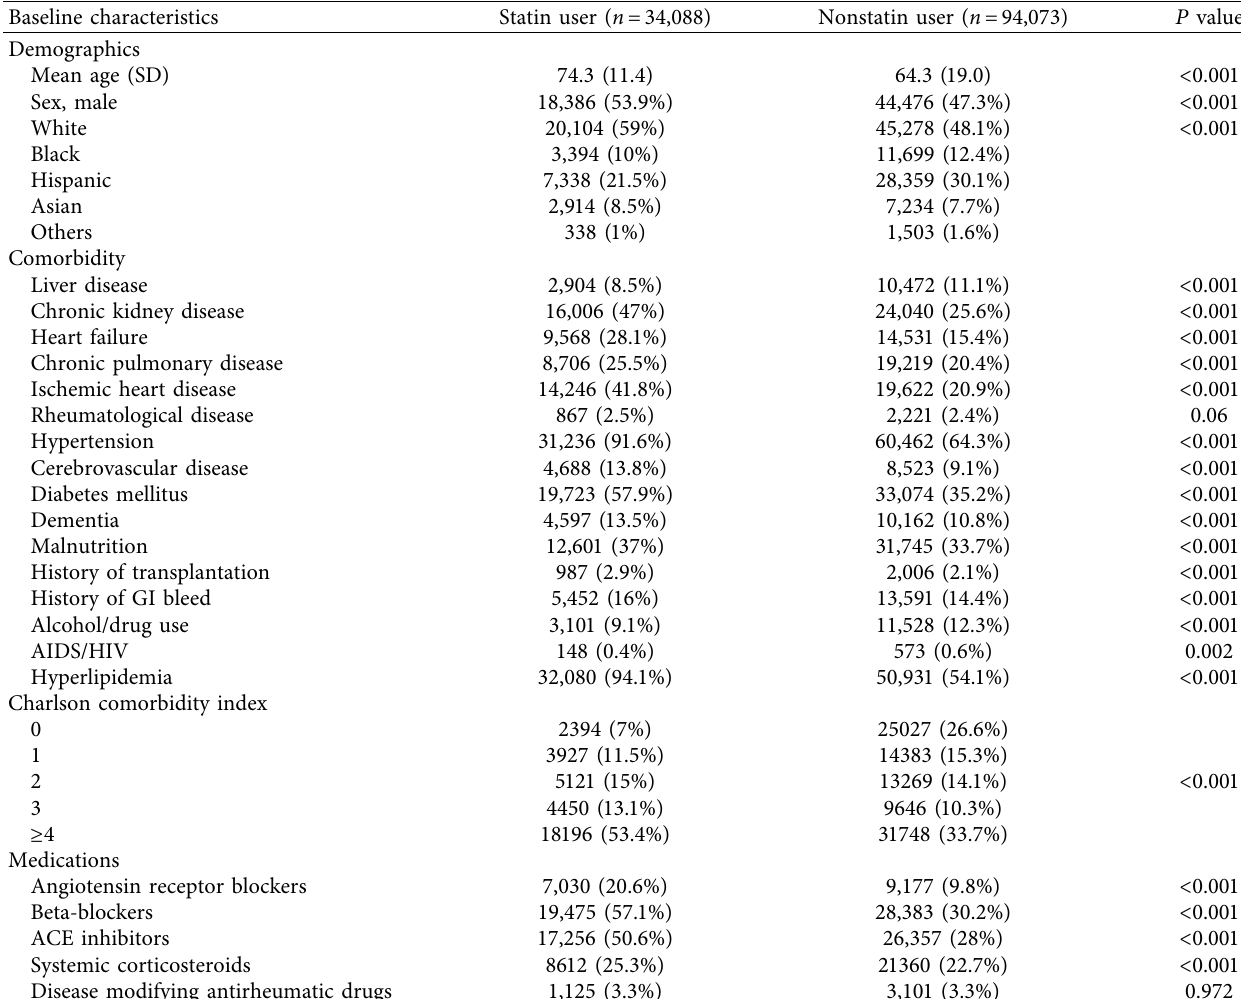
Table 2: Population cohort characteristics. Baseline characteristics are included for the entire study population (those admitted to the hospital with sepsis). Comorbidities were determined as covariates as it relates to risk factors for sepsis